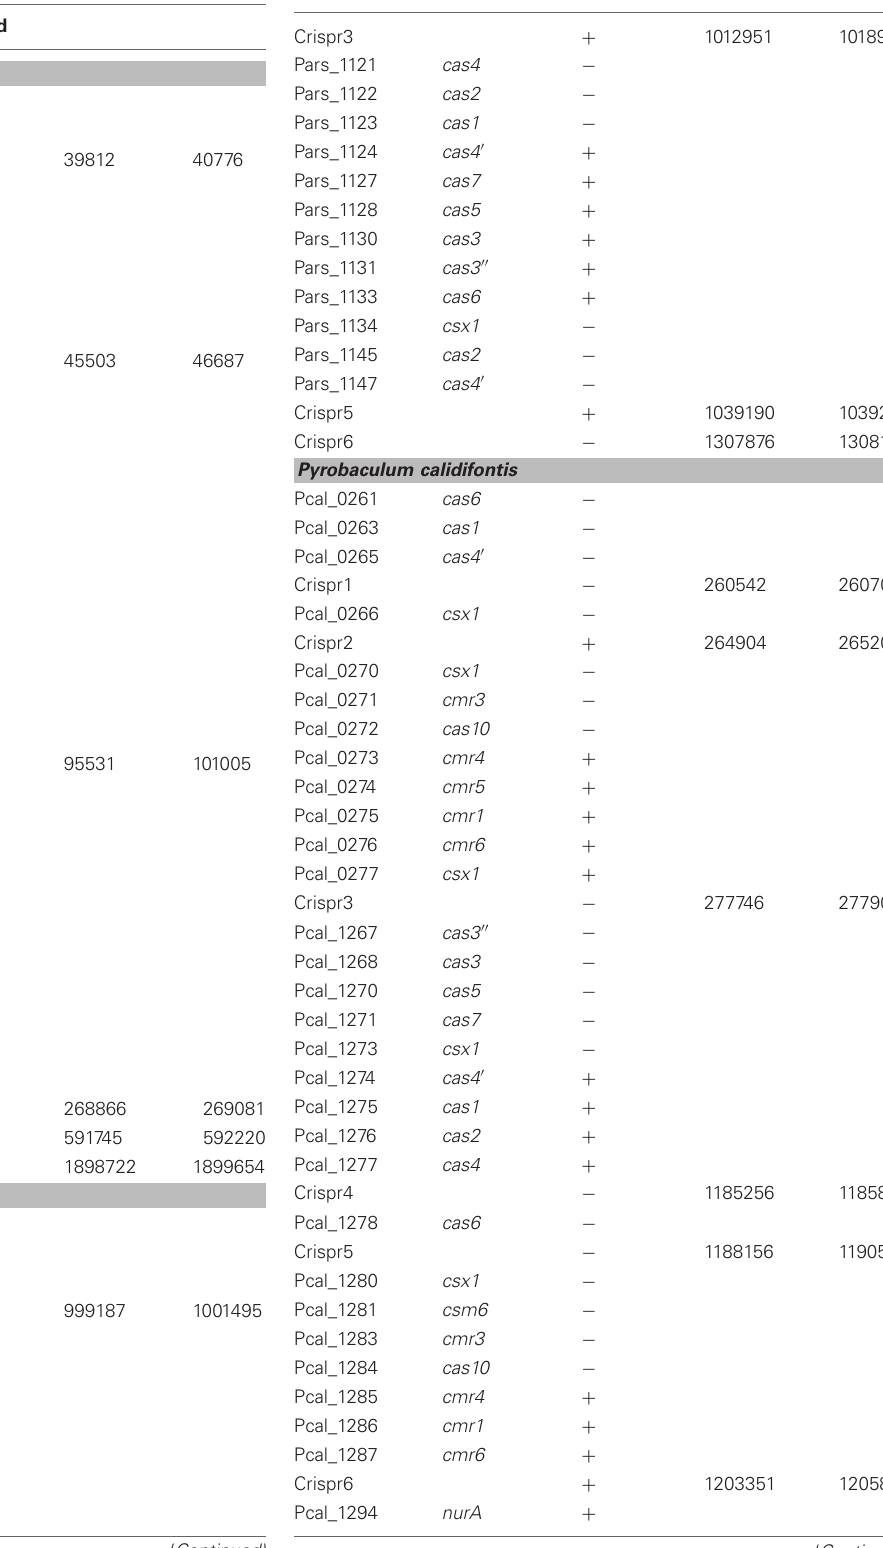
Table A1 | Gene reannotations in Pyrobaculum species